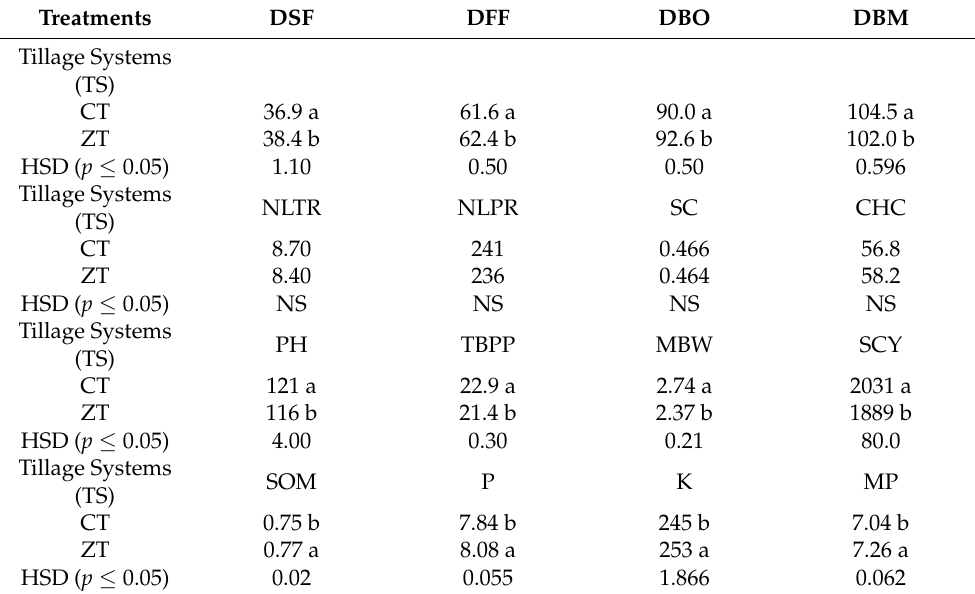
Table 1. Effect of different tillage systems on phenological, physiological, morphological, and yield- related attributes of cotton crop, and soil health indicators.